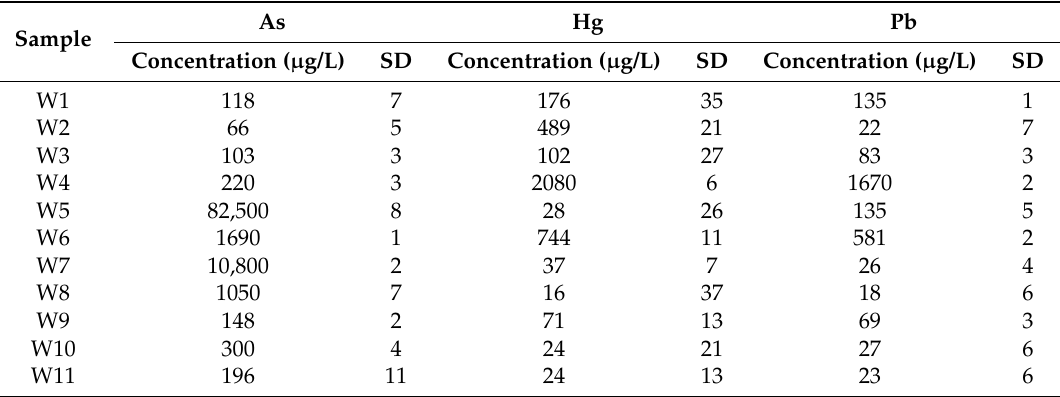
Table 1. Heavy metal concentrations in water samples from the upper course to the lower course of Bone